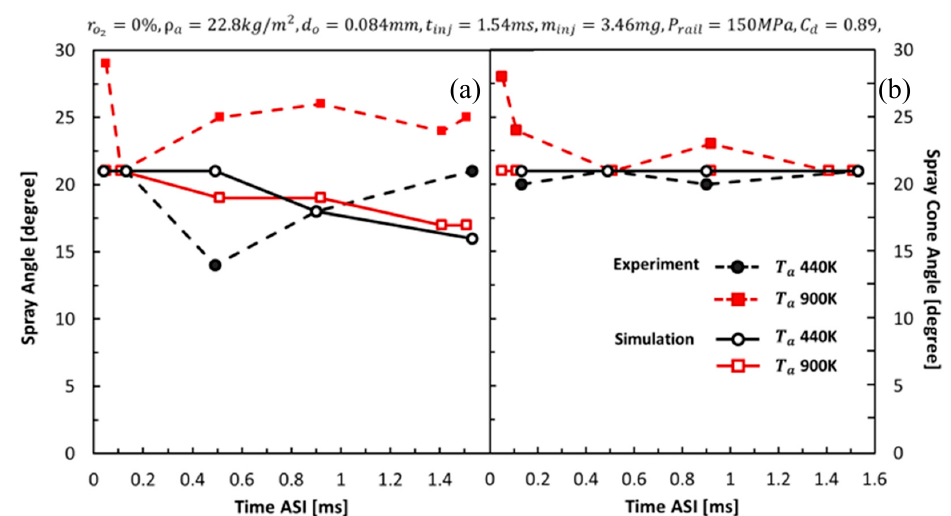
Figure 6. Comparison of the spray distribution angle for different ambient temperatures. ( a ) Spray angle and ( b ) spray cone angle.